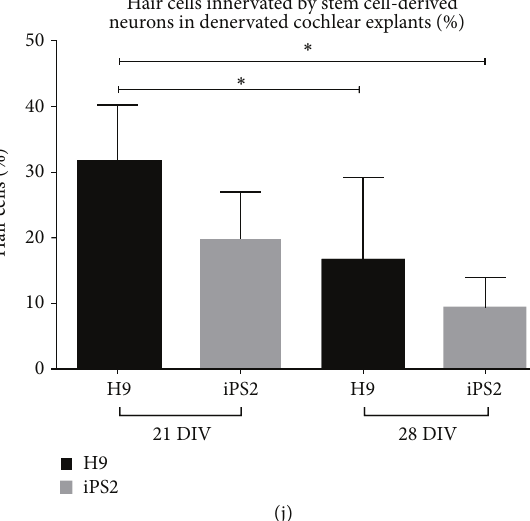
Figure 4: The synaptic potential of 21- and 28-day-old hiPSC- and hESC-derived neurons. (a-b) In the denervated cochlear explant controls at 1 DIV, some accumulation of residual NFM within hair cell somata and a few synaptic puncta were observed. (c-d) After 10 DIV, there appeared to be fewer hair cells with NFM accumulation and synapsin 1 was undetectable. (e) Light microscope image of denervated cochlear explant cocultured with stem cell-derived neurosphere. (f and g) The hiPSC and hESC neurospheres cocultured at 21 DIV extended their neural processes towards hair cells in the denervated explants. Punctate-like synapsin 1 expression was observed along the neural processes of both the hiPSC- and hESC-derived neurites making contact with hair cells. (h and i) The hiPSC and hESC neurospheres cocultured at 28 DIV projected fewer neural processes towards hair cells in the denervated explants. Synapsin 1 was rarely observed along the neural processes of both the hiPSC- and hESC-derived neurites making contact with hair cells. The merged 1 images represent higher magnification images of the boxed inserts and depict the punctate-like synaptic contacts made between the stem cell-derived neural processes and hair cells. Scale bar = 20 𝜇 m (applicable for all images). (j) The 21-day-old hiPSC- and hESC-derived neurons made contact with a significantly higher number of hair cells, compared to the 28-day-old neurons (H9: 𝑝 < 0.05 ). Furthermore, the 21-day-old hESC neurons made contact with a significantly higher number of hair cells ( 𝑝 < 0.05 ). A Student’s 𝑡 -test was used to determine statistical significance. Values of ∗ 𝑝 < 0.05 were considered statistically significant. Data are presented as the mean ±